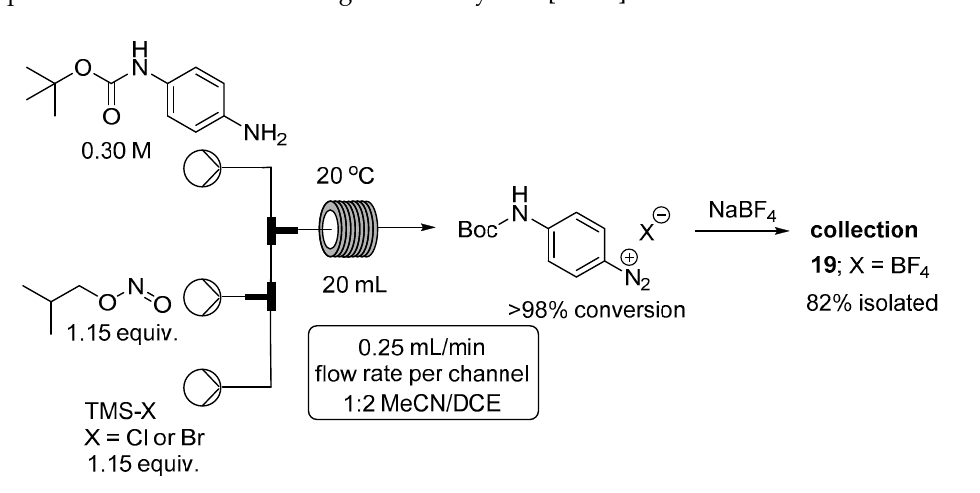
Figure 6. Flow reactor for diazotization of tert -butyl 4-aminophenylcarbamate.